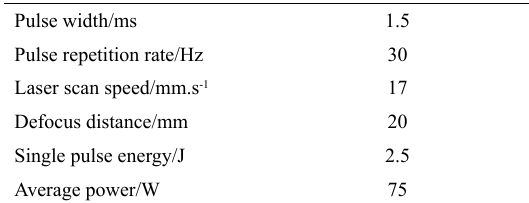
Table 1. Laser parameters used in present